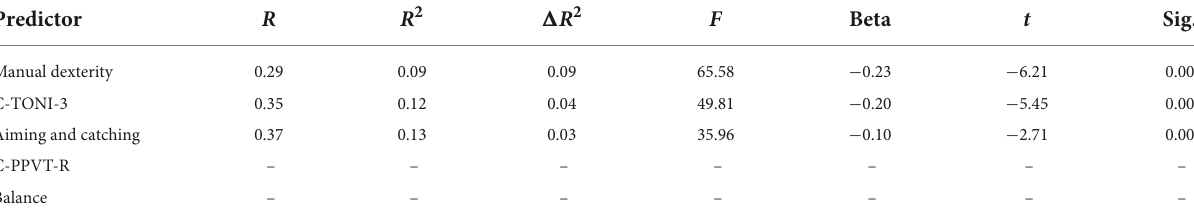
TABLE 8 Linear regression analysis for the predictive effect of subtest of MABC-2 on object RAN.